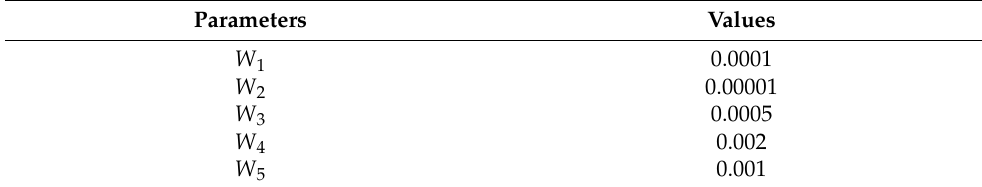
Table 1. Parameters of model used in